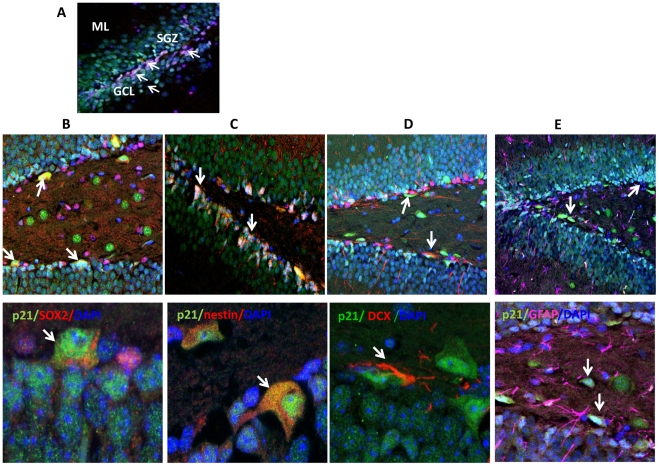
p21 is expressed in neuronal progenitors in the SGZ of the hippocampus.
A) The confocal image shows that p21 (red) is expressed in the SGZ of the dentate gyrus and is not expressed in mature neurons (NeuN, green) in the GCL. Here, and in other confocal images, nuclei are stained with the DNA specific dye DAPI (blue). p21-positive cells appear pink. p21 is expressed mostly in nuclei; however, some cytoplasmic staining also is observed. SGZ, subgranular zone; GCL, granular cell layer; ML, molecular layer; B–E) Confocal images depicting p21 co-localization with neuronal markers in the SGZ of the hippocampus. p21-positive nuclei line the SGZ and appear light blue. Upper panel-low magnification (x20), lower panel–higher magnification (x63). B) p21 (green) is co-localized with SOX2 (intranuclear, red). Cells that express both proteins appear yellow; cells that expressed SOX2 only appear pink; C) p21 (green) is co-localized with nestin (cytoplasmic, red); D) p21 (green) is co-localized with DCX (cytoplasmic, red); E) p21 (green) is not co-localized with GFAP (cytoplasmic, pink). Some of p21 positive cells are marked with arrows.